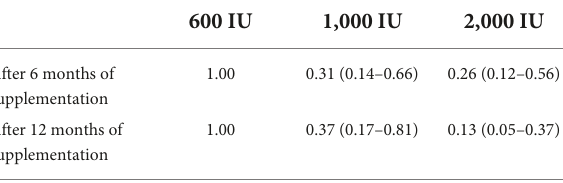
TABLE 2 Odds ratios (95% confidence interval) of vitamin D deficiency among intervention